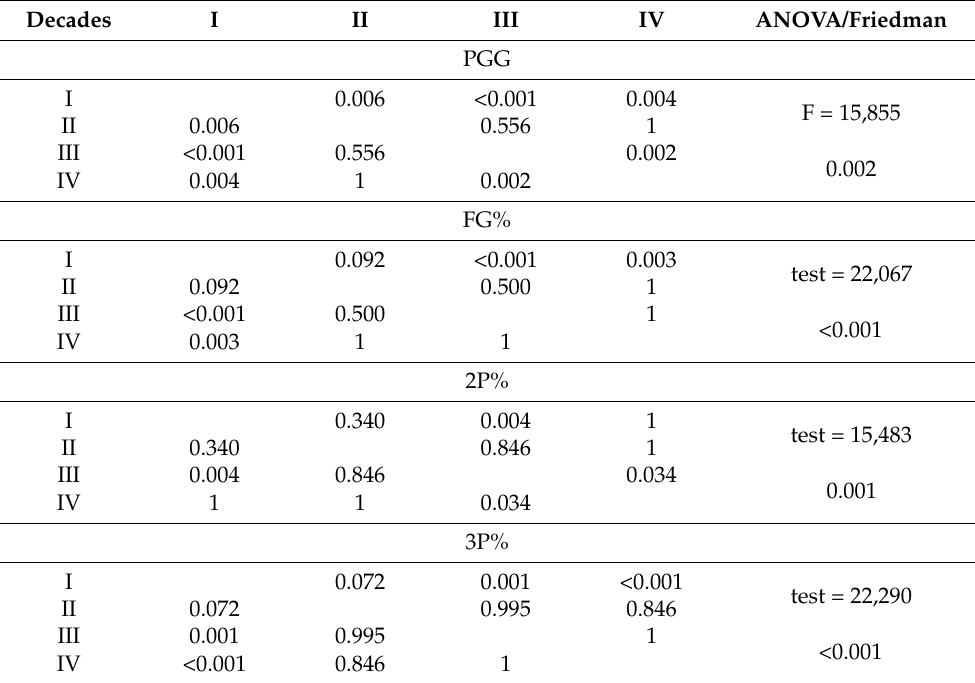
Table 3. Results of ANOVA or Friedman tests and post hoc comparisons between decades for PPG, FG%, 2P%, and